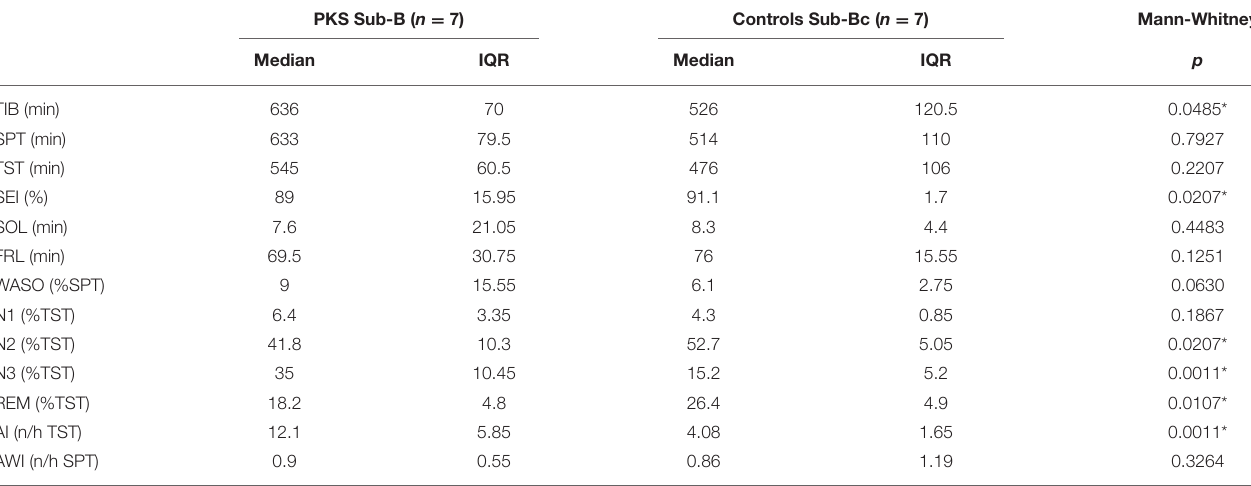
TABLE 4 | VPSG data of subgroup B (11–17 y) compared with control subgroup Bc (11–16 y). PKS Sub-B ( n = 7) Controls Sub-Bc ( n =